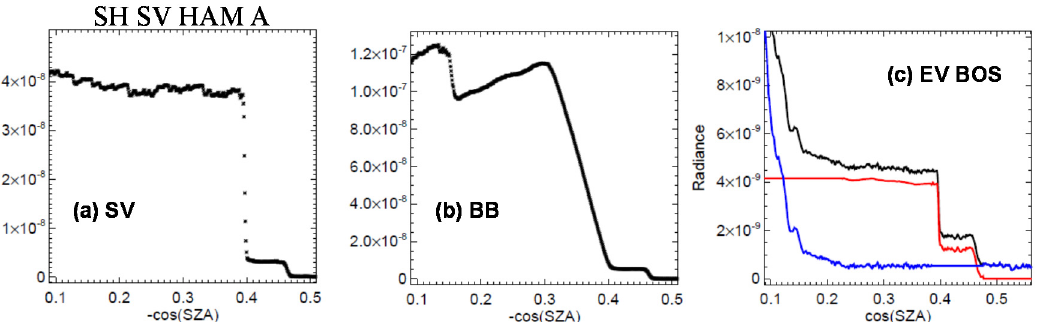
Figure 9. DNB detector of eight dark signals near the southern hemisphere stray light problem regions on September 5, 2013 for ( a ) SV, ( b ) BB, and ( c ) EV at BOS. Black curves are computed dark signals, red curves are estimated stray light, and blue curves are the signals after stray light correction. SZA = solar zenith angle.